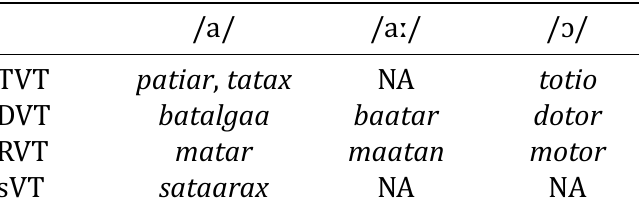
Table A.4: C₂ fortis plosive in polysyllables